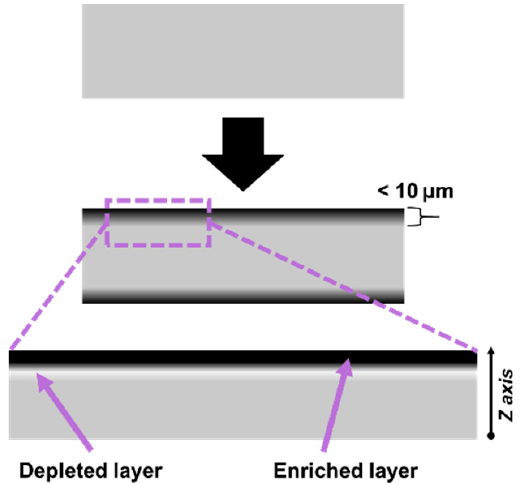
Figure 15. Schematic illustration of the assumed distribution of the electrically conductive filler before ( above ) and after ( below ) holding the composite material in a melt state.